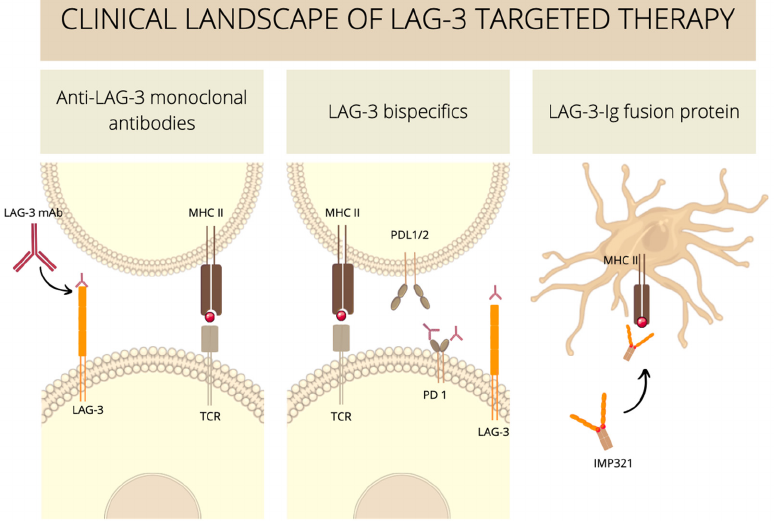
Figure 5. Schematic representation of LAG-3-targeted therapies: anti-LAG-3 monoclonal antibodies, and bispecific LAG-3, LAG-3 (Ig) immunoglobulin fusion proteins.